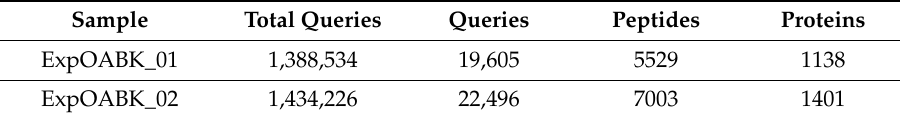
Table 3. The number of identified peptides and proteins in both